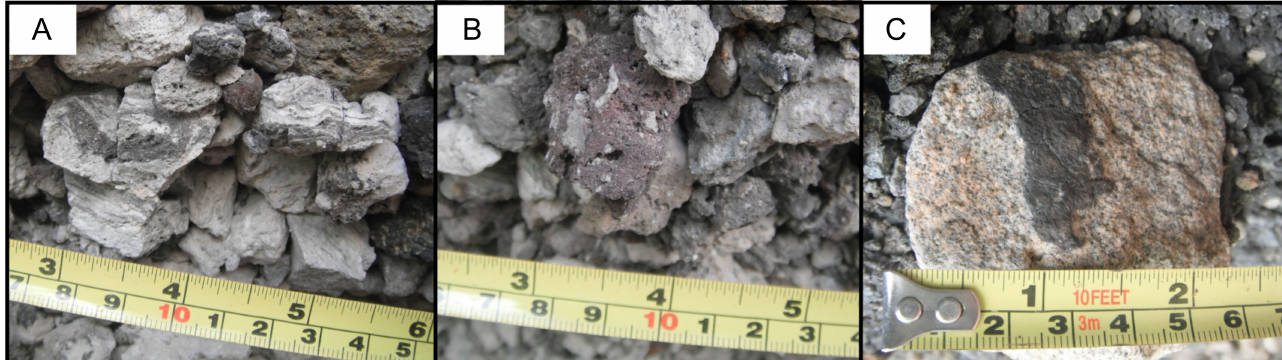
Figure 2: The mingled fall deposit of Ascension Island. Sample locations shown by the red arrows, and subunits labelled as A, L1A, L1B, L2A, L2B, L3. Tape measure is extended to 20 cm for scale.